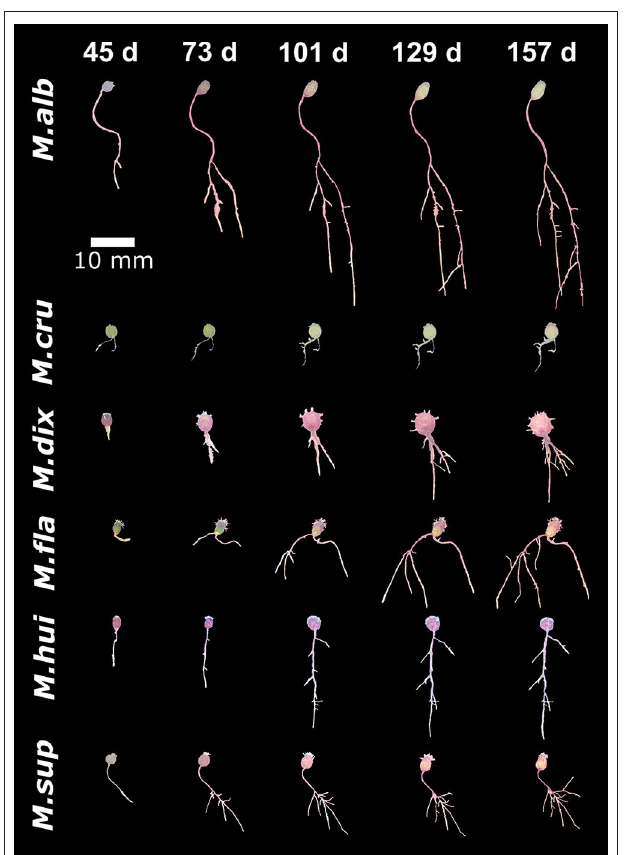
FIGURE 4 | Growth dynamics in Mammillaria species from the Series Supertextae over five developmental stages (45, 73, 101, 129, and 157 days after germination). For simplicity, acronyms of these species were created as follow: M.alb , M. albilanata ; M.cru , M.crucigera ; M.dix , dixanthocentron , M.fla , M. flavicentra ; M. hui , M. huitzilopochtli ; M.sup , M. supertexta .